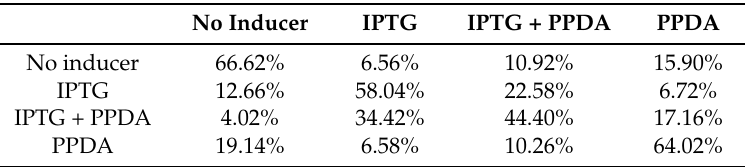
Table 2. PLS predictions of the riboswitch set. Confusion matrix of inducer condition prediction using structured output .